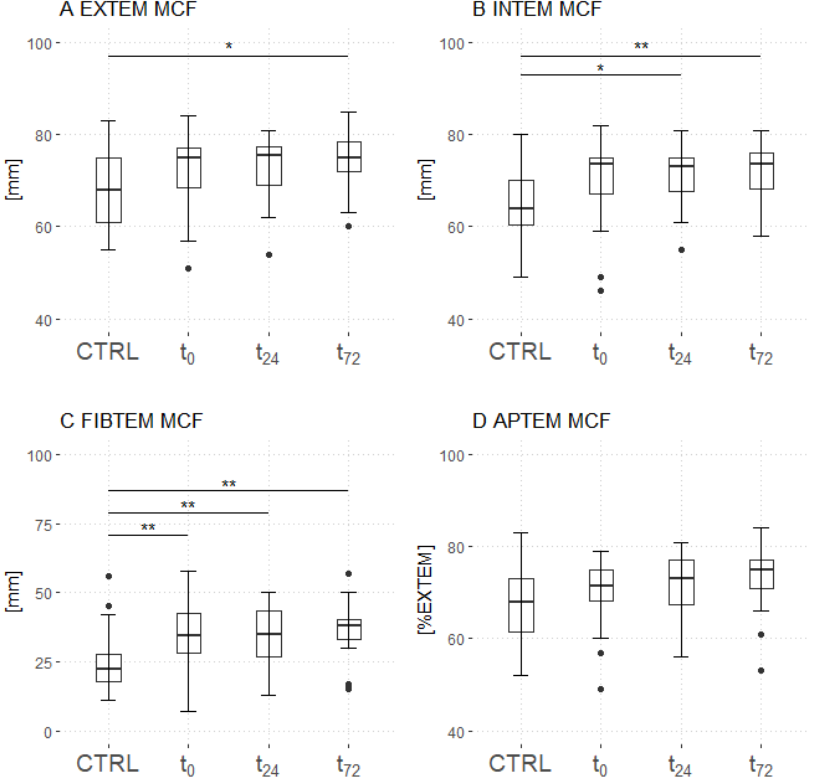
Figure 3. Time course of thromboelastometry. Patients with COVID-19 presented a significantly increased MCF at 72 h (EXTEM ( A ) and INTEM ( B ) assays) and 24 h (INTEM ( B )) after admission to the ICU compared with the controls. In the FIBTEM assay ( C ), the MCF increased in patients with COVID-19 at all time points compared with that in the controls. No differences were found in the APTEM assay ( D ). Asterisks display the degree of statistical significance: *: p ≤ 0.05, **: p < 0.01. Abbreviations: APTEM = aprotinin-based thromboelastometry; CTRL = control group; EXTEM = extrinsically activated thromboelastometry; FIBTEM = fibrinogen-based thromboelastometry; INTEM = intrinsically activated thromboelastometry; MCF = maximum clot firmness.